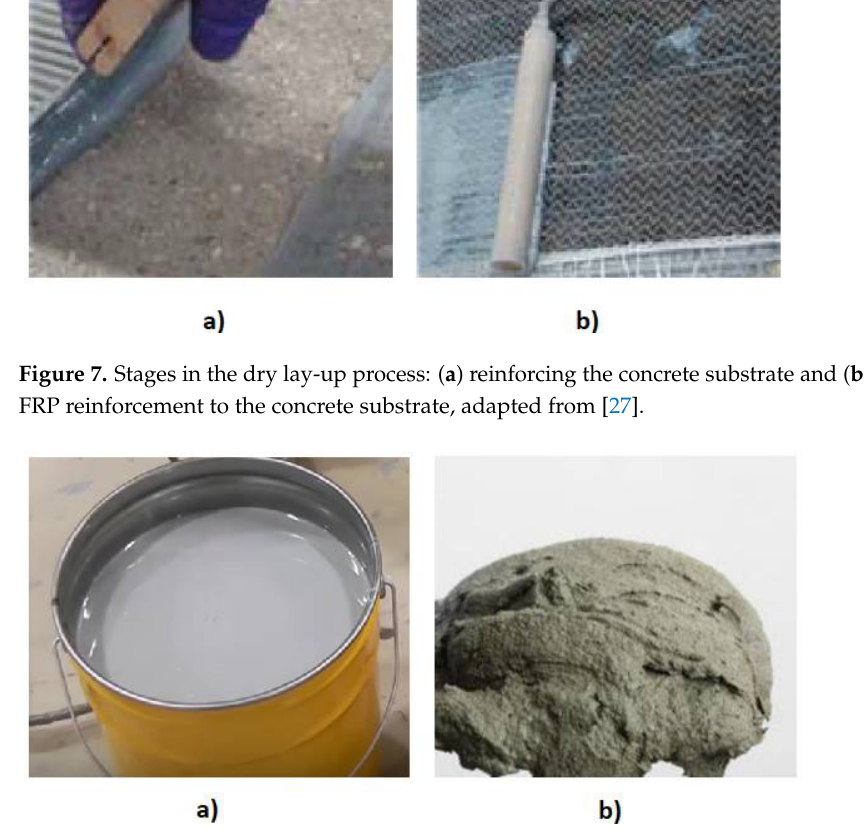
Figure 7 . Stages in the dry lay-up process: ( a ) reinforcing the concrete substrate and ( b ) applying the FRP reinforcement to the concrete substrate, adapted from [27].